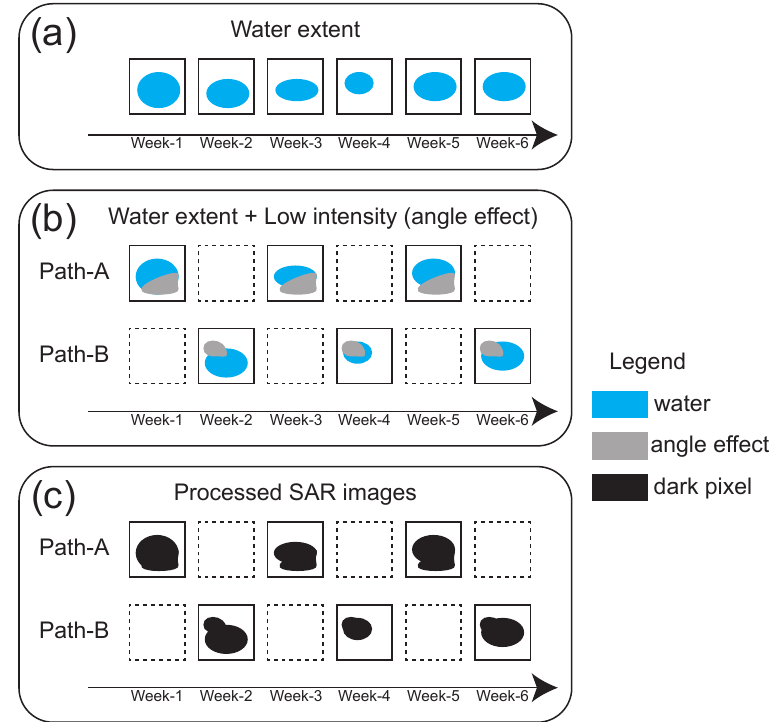
Figure 2. ( a ) Supposing that the water extent changes over time, ( b ) SAR can capture this wetland from Path-A and Path-B and ( c ) Processed SAR images in which water and low intensity derived from the angle effect cannot be